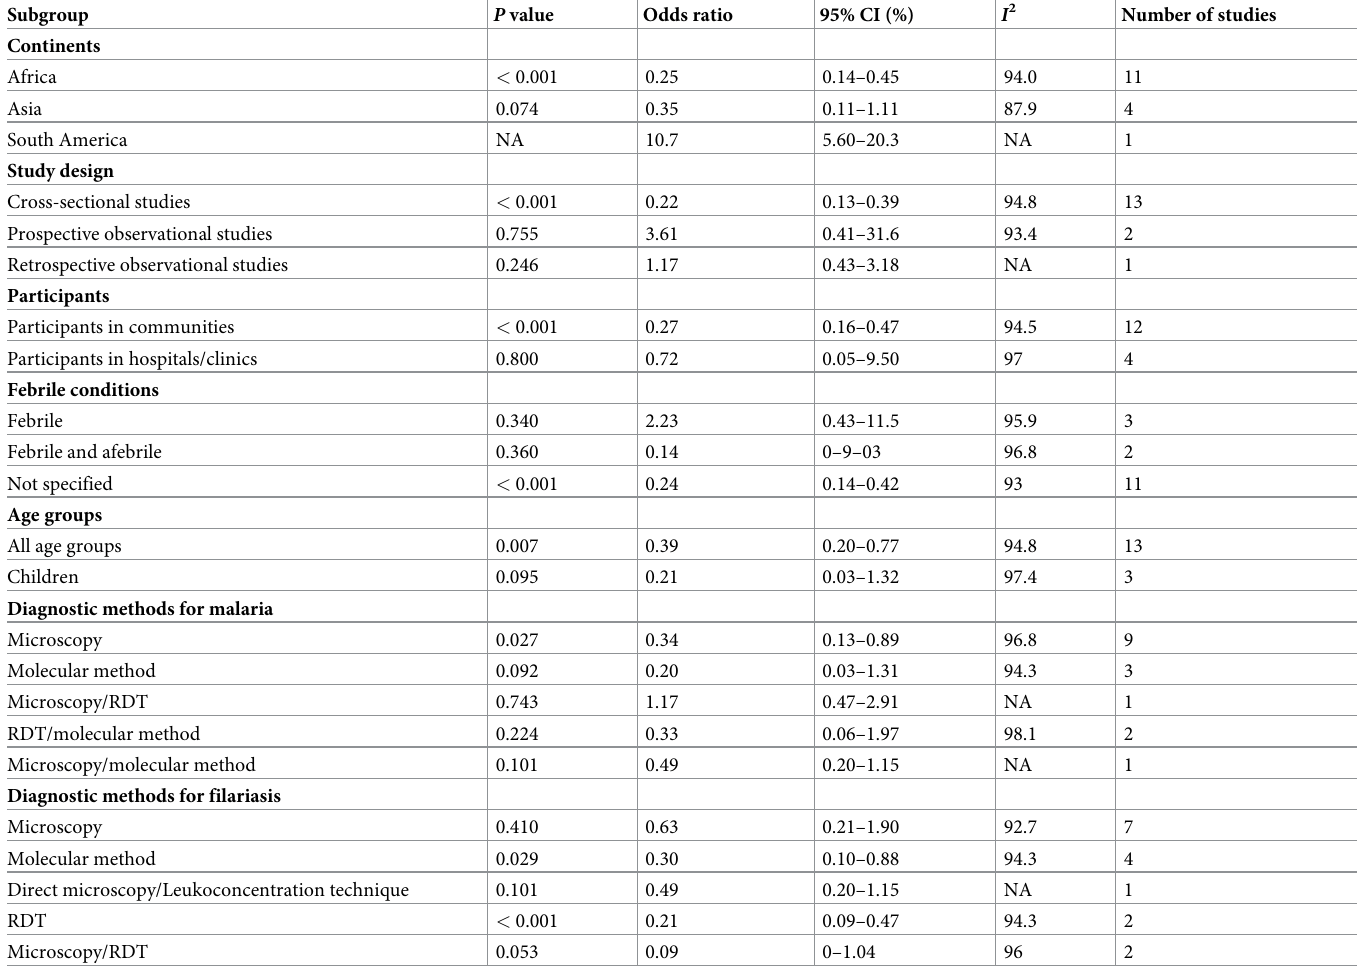
Table 4. Subgroup analysis of the probability of co-infections among selected